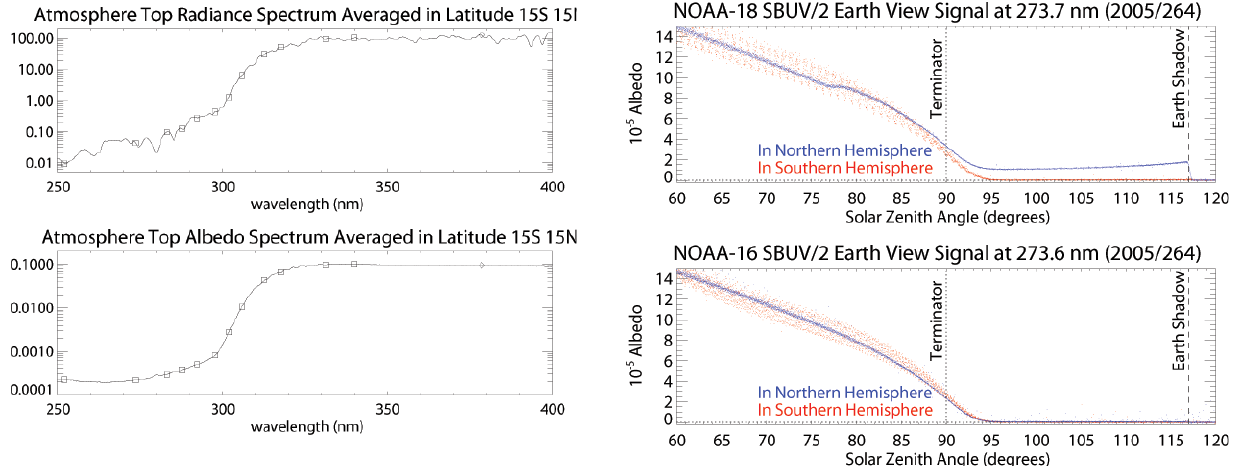
Fig. 2. Comparison of SBUV/2 earth view (radiance) signals at 273nm between NOAA-18 (top panel) and NOAA-16 (bottom panel). The IBSL error in NOAA-16 data is negligible. NOAA-18 SBUV/2 data have significant IBSL errors at SZA > 77 ◦ approach- ing the terminator near North Pole. NOAA-16 and NOAA-18 orbits were in proximity at the Equator crossing local times of 14:59 and 14:01, respectively, to minimize diurnal difference in the earth radi-